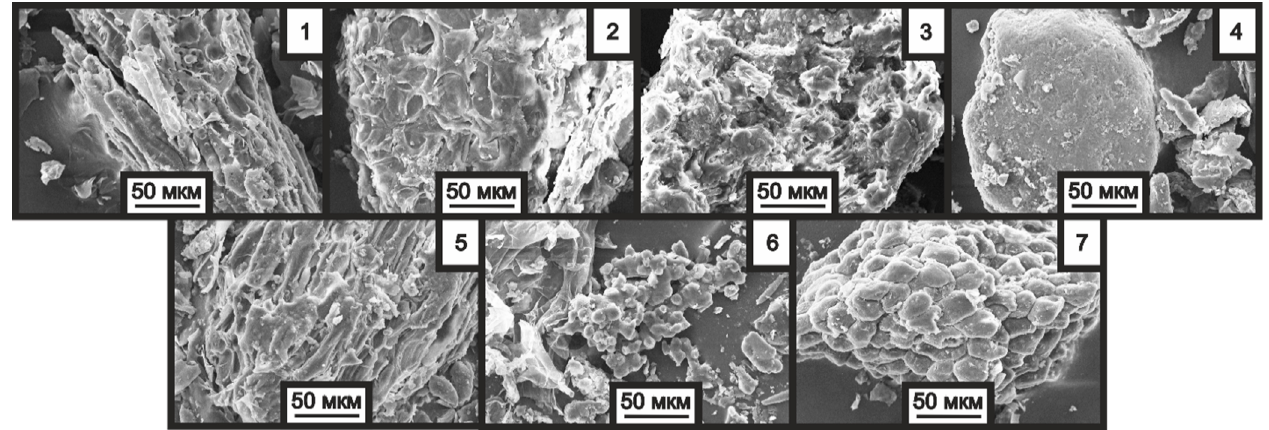
Figure 2. SEM images of nut shell samples: 1—Pine, 2—Hazelnut, 3—Walnut, 4—Macadamia, 5—Almond, 6—Peanut, 7—Pistachio. Particle size is less than 200 μм (×500).